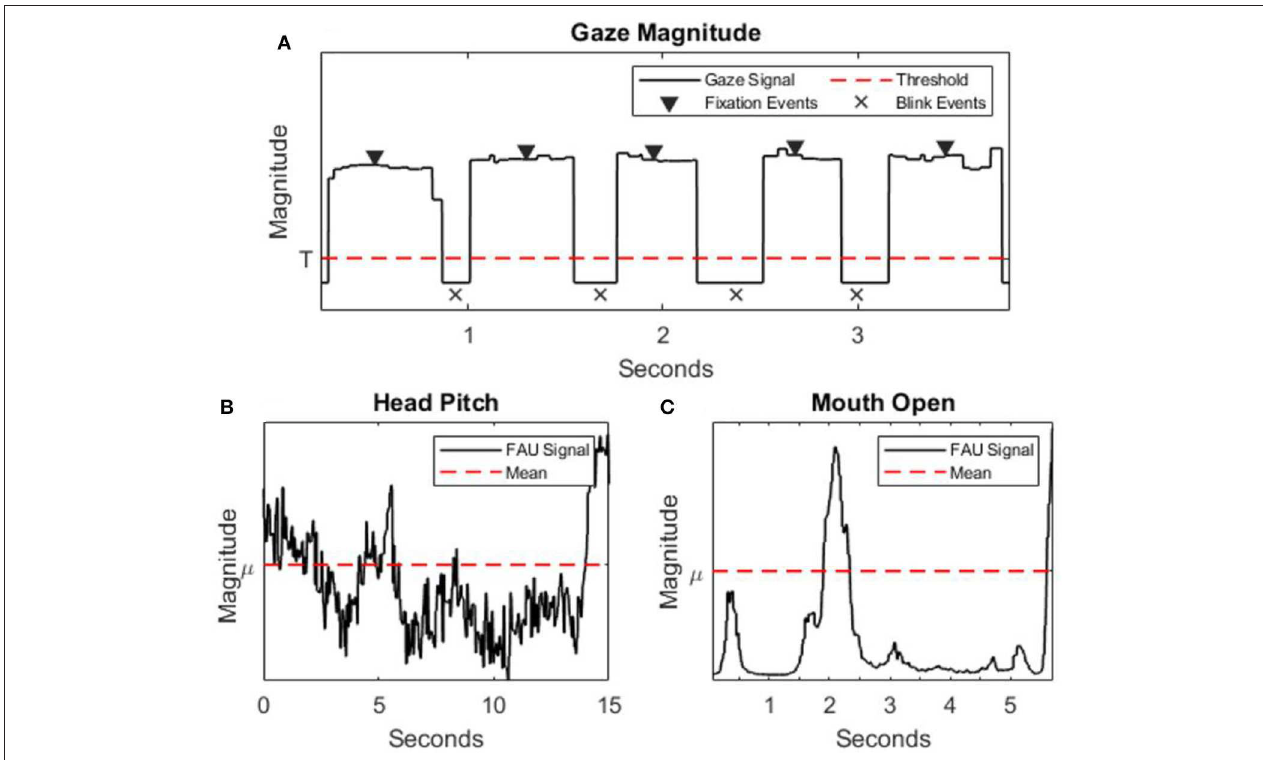
FIGURE 3 | (A) Eye coordinate magnitude signal (solid black line), threshold for defining blink events (dotted red line), and highlights fixation/blink events (triangles/x’s, respectively). (B,C) Examples of FT signals (solid black line)—mouth open and head pitch, respectively—with mean value (dotted red line).